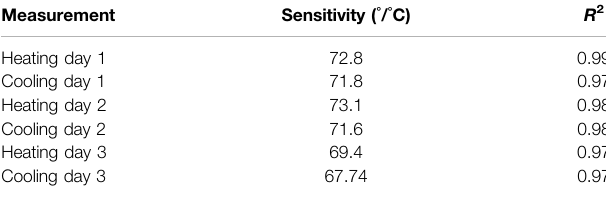
TABLE 4 | LC2 patch sensitivity in effective temperature region 34 – 37.1 ° C.